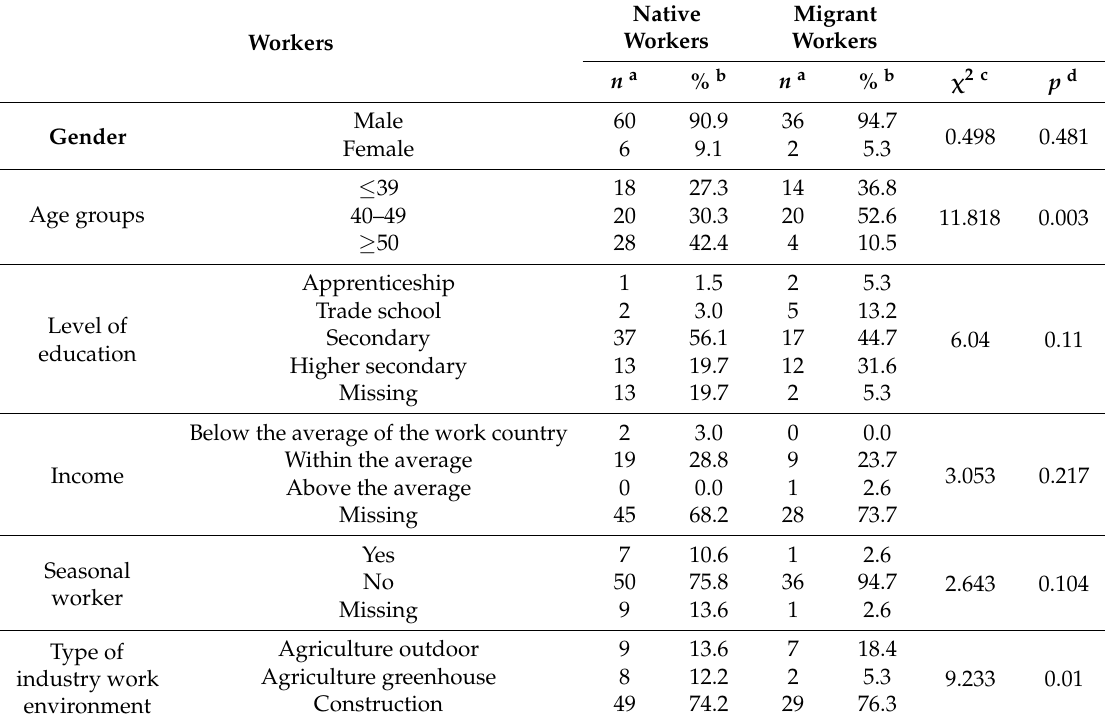
Table 2. Sample characteristics and statistical